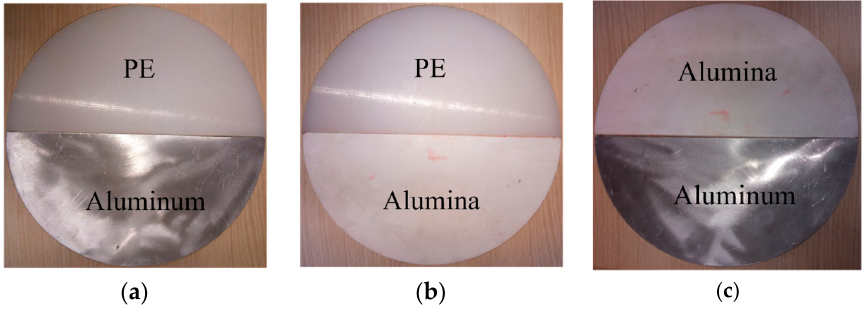
Figure 1. The proposed turntable structure and the corresponding experimental